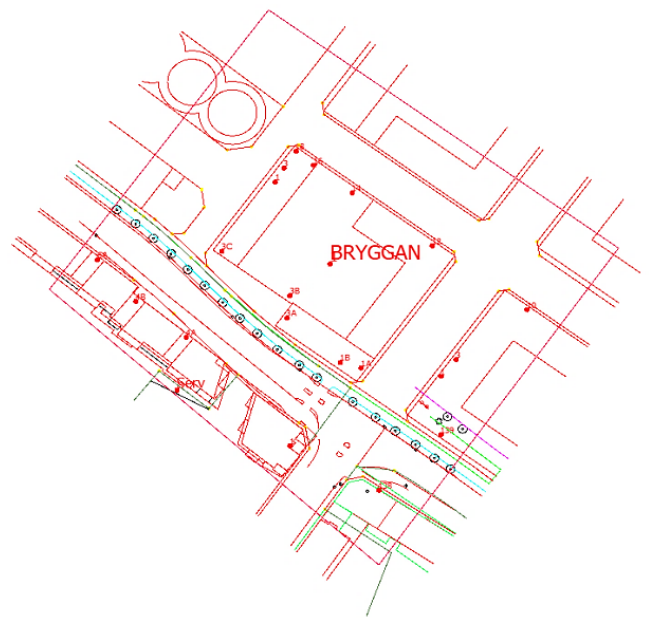
Figure 7. 2D cadastral index map (Source: Malmö municipality). Note that this index map does not show the subdivision of the property Bryggan.